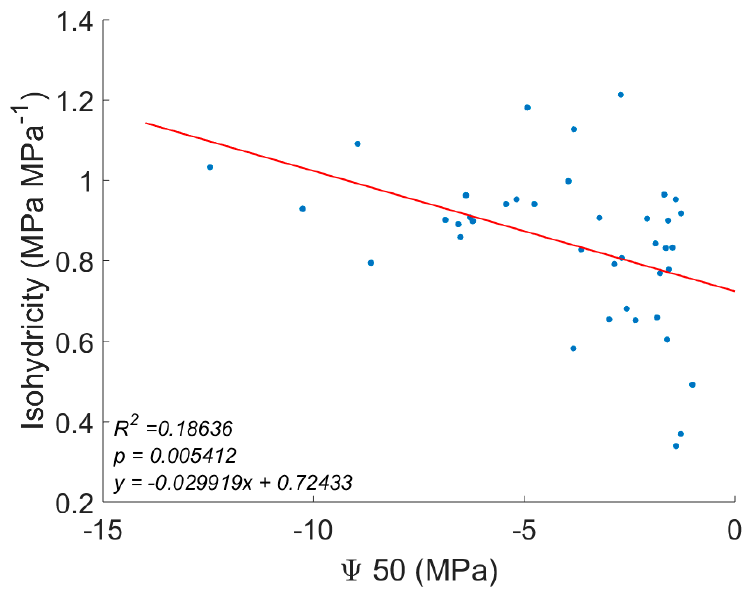
Figure 1. More isohydric species (isohydricity closer to 0) maintain less negative Ψ 50 by combatting high VPD with stomatal control. ( R 2 = 0.19, p = 0.005) Markers represent individual species ( n = 40).